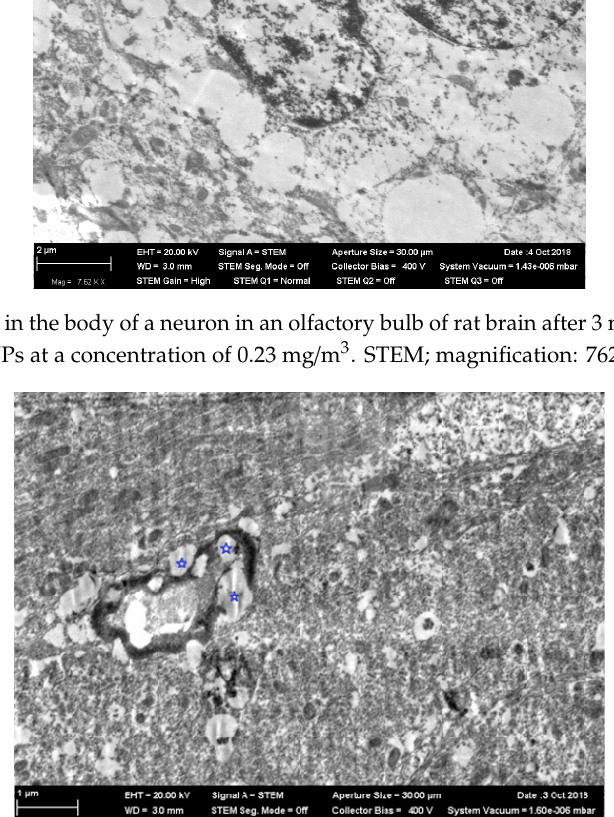
Figure 3. Demyelinized sites (noted with asterisks) on the fibers of an olfactory bulb of rat brain after 3 months of inhalation exposure to NiO-NPs at a concentration of 0.23 mg/m 3 . STEM; magnification: 11770×.